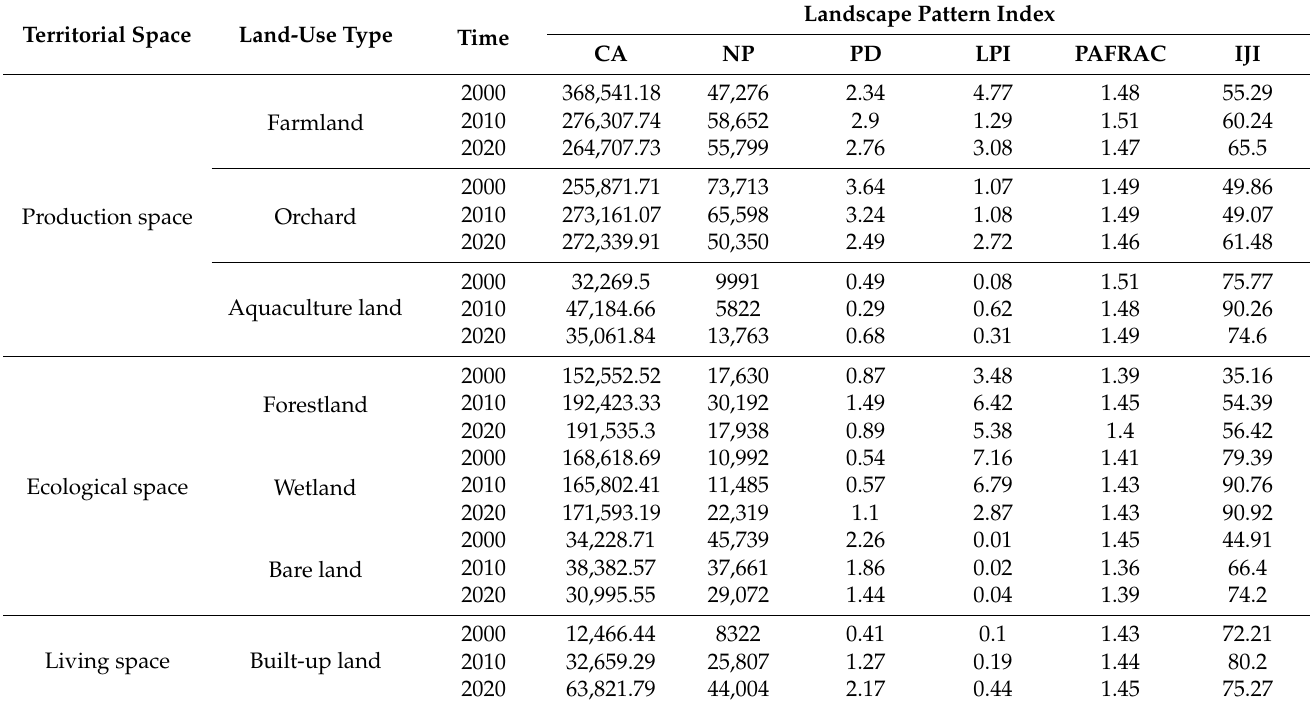
Table 7. Landscape pattern indexes for class scale in the study